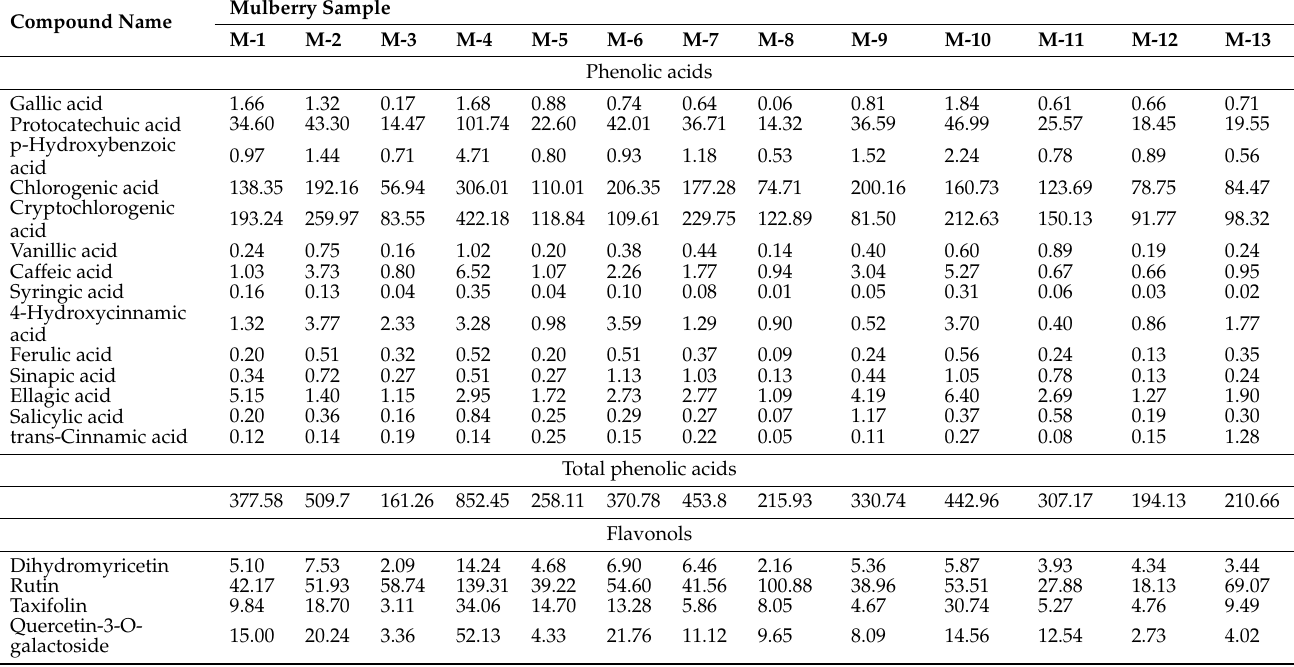
Table 3. Phenolic compound contents (mg/kg DW) in the mulberry samples of different